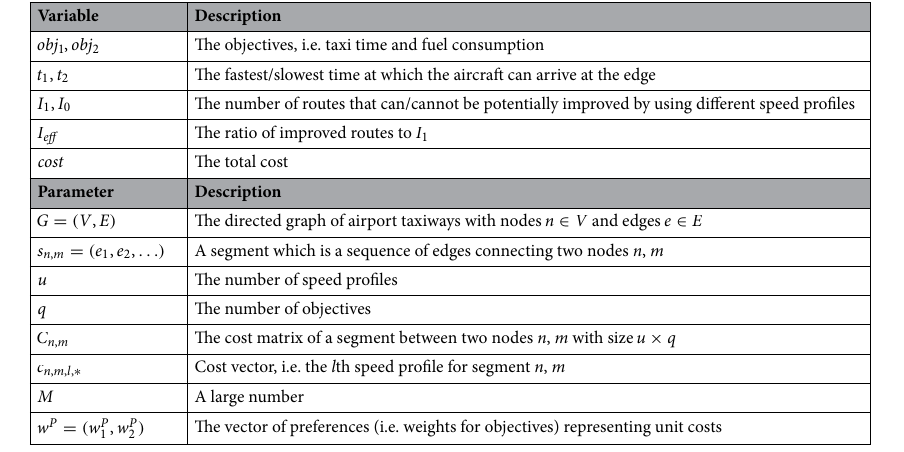
Table 1. Notations used throughout the paper.